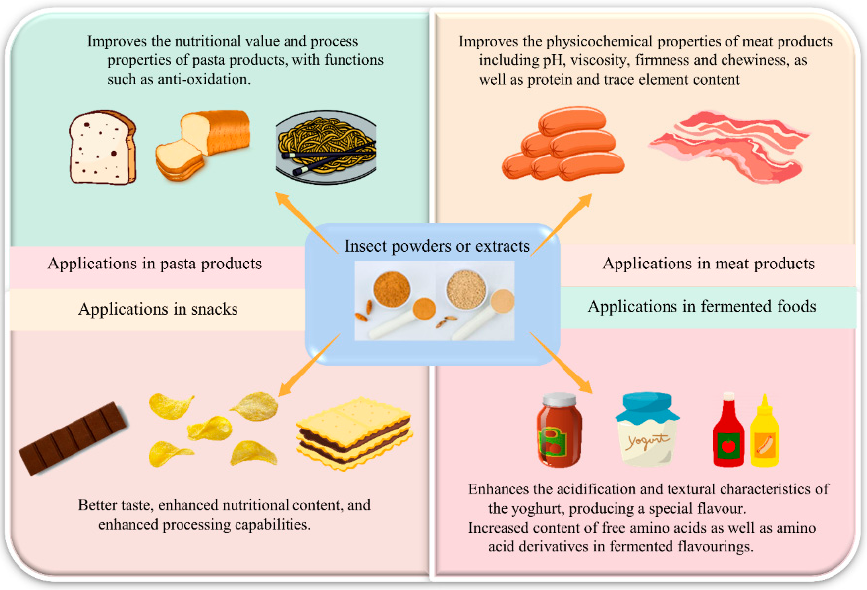
Figure 9. Edible insects in food applications.